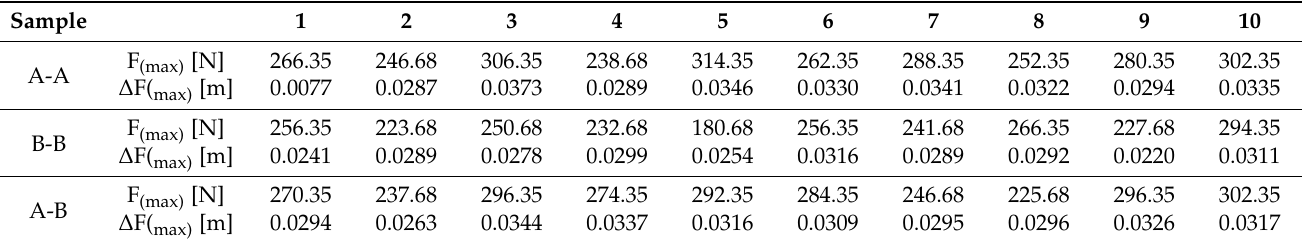
Table 5. Soft 10 fabric test results.